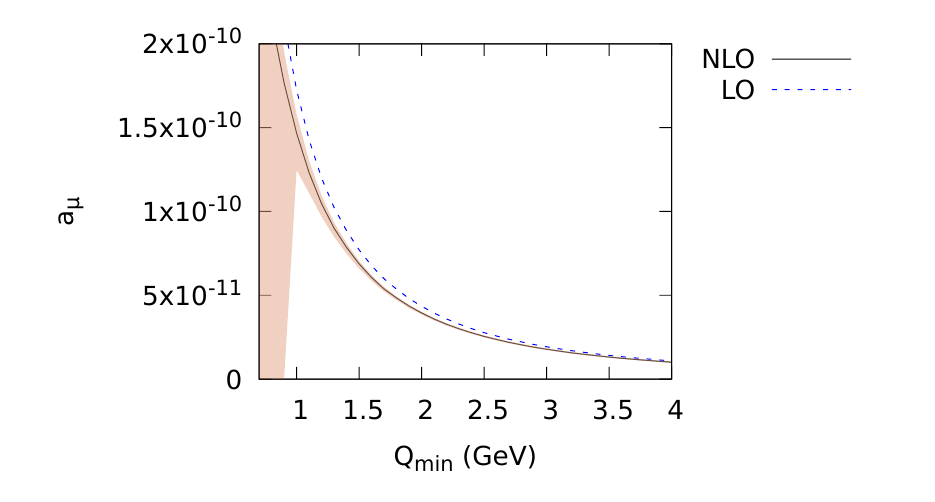
˜ ⇧ ˜ ⇧ ˜ ⇧ ˜ ⇧ ˜ ⇧ 1 7 10 13 19 Quark loop 0 . 0816 0 . 123 0 . 0363 0 . 0274 0 . 0263 − ⇡/↵ . 0781 Gluon corrections ( 0 . 136 0 . 0376 0 . 0398 0 . 0411 s ) 0 ⇥ − − − − Table 1. Values for the quark loop and gluonic correction contributions to the ˜ ⇧ in GeV units for a , Q 2 , Q 2 benchmark tuple ( Q 2 ) = (1 , 1 . 3 , 1 . 7) GeV 2 . Sum over the three flavours has been made. The 1 2 3 last line is in units of ↵ s /⇡ .